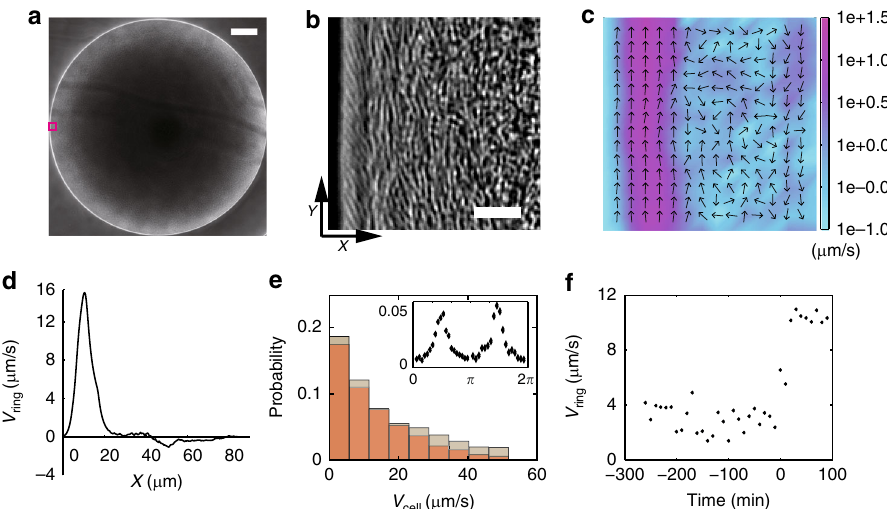
Fig. 1 Self-organization of two adjacent colony-scale motile rings at the edge of a P. mirabilis colony. a Phase contrast image of P. mirabilis colony. Scale bar, 0.5 mm. b Enlarged view of the area enclosed by magenta box in panel A. Scale bar 10 μ m. Also see Supplementary Movie 1. c Time-averaged collective velocity fi eld of cells in the region of panel b computed by optical fl ow analysis ( “ Methods ” ) based on phase contrast images. The collective velocity fi eld was averaged over a duration of 10 s. Arrows represent velocity direction, and colormap represents velocity magnitude in log scale (with the color bar provided to the right, in μ m s − 1 ). d The mean tangential speed of collective cellular motion (based on optical fl ow data) plotted against the distance from colony edge. Positive value of speed indicates motion along CW direction, i.e., along + Y axis of the coordinate system speci fi ed in panel b , and X = 0 is set at the position of colony edge. e Speed distribution of individual bacteria at the inner motile ring moving in CCW direction (gray) and in CW direction (brown). Cell speed was computed by tracking fl uorescent cells seeded into the colony ( “ Methods ” ) and located near the center of inner motile ring where the magnitude of mean tangential speed was larger than 1/3 of the maximum CCW velocity magnitude in panel d . Inset: Probability distribution of velocity direction, with 3/2 π and 1/2 π corresponding to − Y and + Y directions, respectively. See Supplementary Fig. 1 and Supplementary Movie 2. f Dynamics of motile ring emergence during colony growth. The mean tangential speed of bacteria (computed by optical fl ow analysis with phase contrast images) in the 10- μ m-wide outmost rim of colonies (i.e., the region of outer motile ring) is plotted against time. Time = 0 min is chosen at the onset of collective motion with high polar order and it corresponds to ~20 h colony